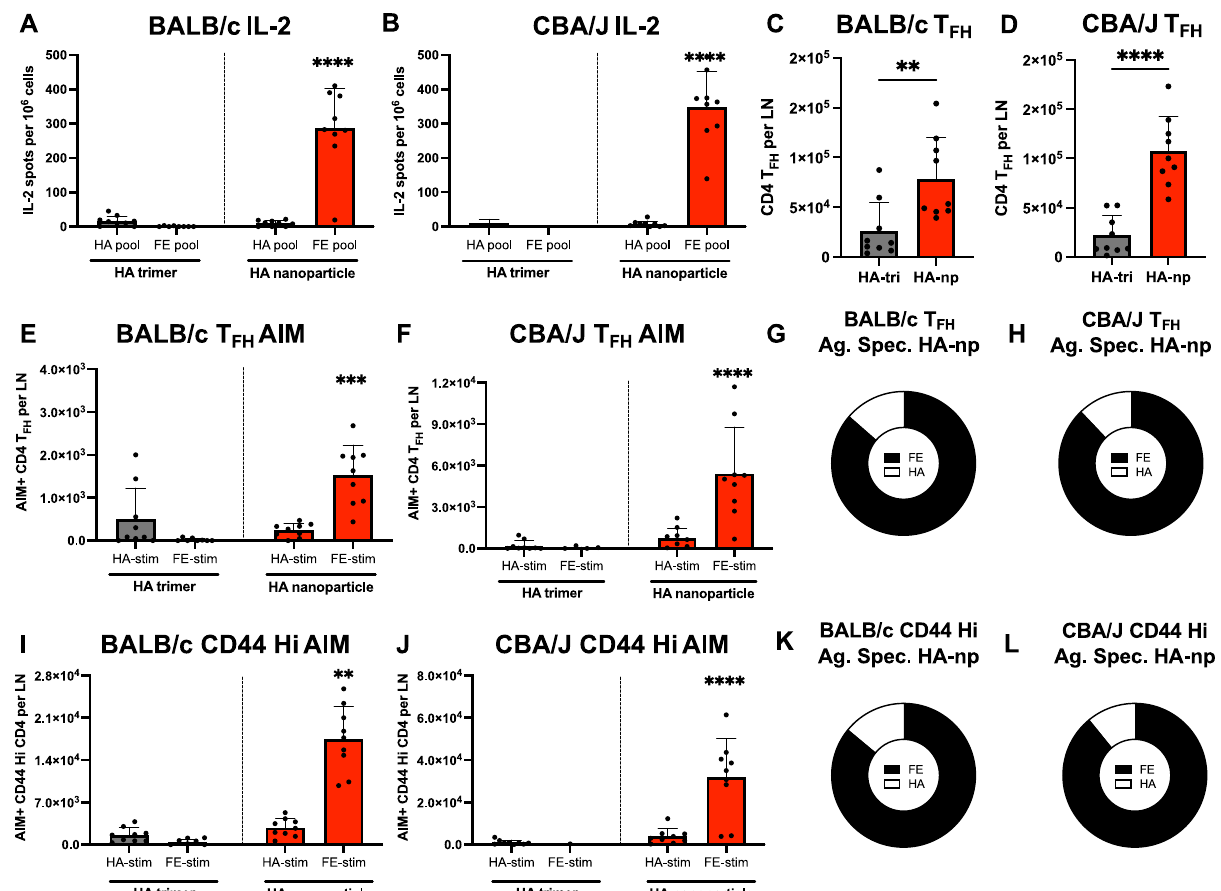
Fig. 3 Ferritin-speci fi c CD4 T cells participate in the germinal center response to HA-nanoparticle immunization. BALB/c and CBA/J mice were immunized with equimolar quantities of HA in the form of soluble HA trimers or HA-nanoparticles. Draining lymph nodes were harvested D15 post immunization. Antigen-speci fi c CD4 T cell responses were quanti fi ed by IL-2 ELISpot for A BALB/c mice and B CBA/J mice following stimulation with total HA or total ferritin peptide pools. Absolute numbers of CD4 T FH per lymph node were quanti fi ed for C BALB/c and D CBA/J. Antigen speci fi city of the T FH response was quanti fi ed by activation induced marker (AIM) assay by scoring upregulation of CD154 and CD69 in response to peptide stimulation for E BALB/c and F CBA/J. The fraction of the AIM + T FH speci fi c for ferritin (black) or HA (white) is shown for G BALB/c and H CBA/J. Quanti fi cation of antigen experienced non-T FH that upregulate CD154 and CD69 in response to peptide stimulation for I BALB/c and J CBA/J. The fraction of the AIM + antigen experienced CD4 T cell responses speci fi c for ferritin (black) or HA (white) is shown for K BALB/c and L CBA/J. Data are shown as the mean and SD three individual mice per group from three independent experiments, for a total of 9 individual mice per group. In A , B , E , F , I , J , signi fi cant differences between HA-trimer and